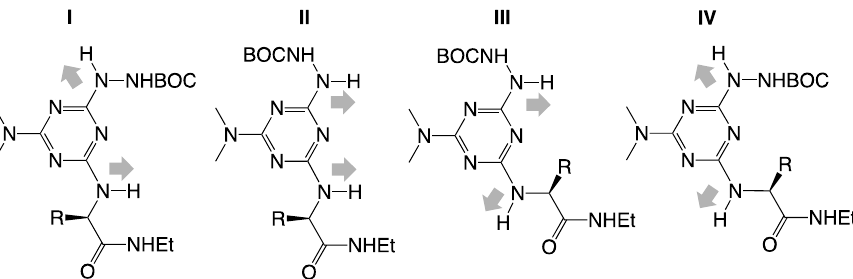
Chart 2. Rotamers of a substituted triazine. The arrows indicate the orientation of hydrogen atoms, intended to guide the eye in distinguishing rotamers.